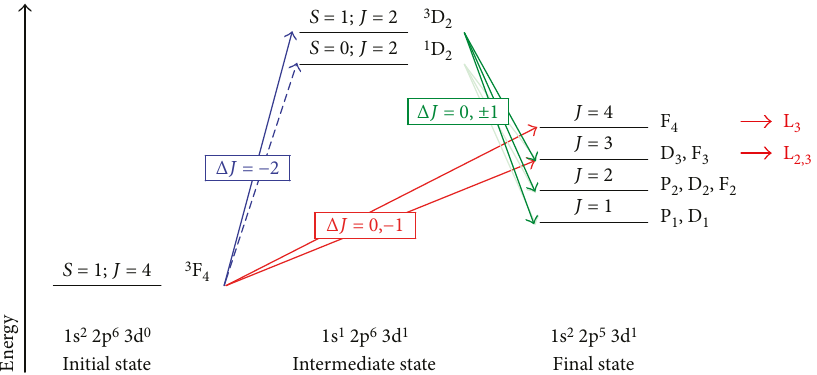
Figure 16: Atomic term scheme with spin-orbit coupling for Ni 2+ comparing the two-step (1s XAS, 2p XES) 1s2p RIXS and the one-step 2p XAS pathways. Here, it should be noted that the two IS terms are only separated by the small 3d SOC ζ Ti 4+ . Nonaccessible terms (e.g., fi nal states with J = 0 ) are omitted for